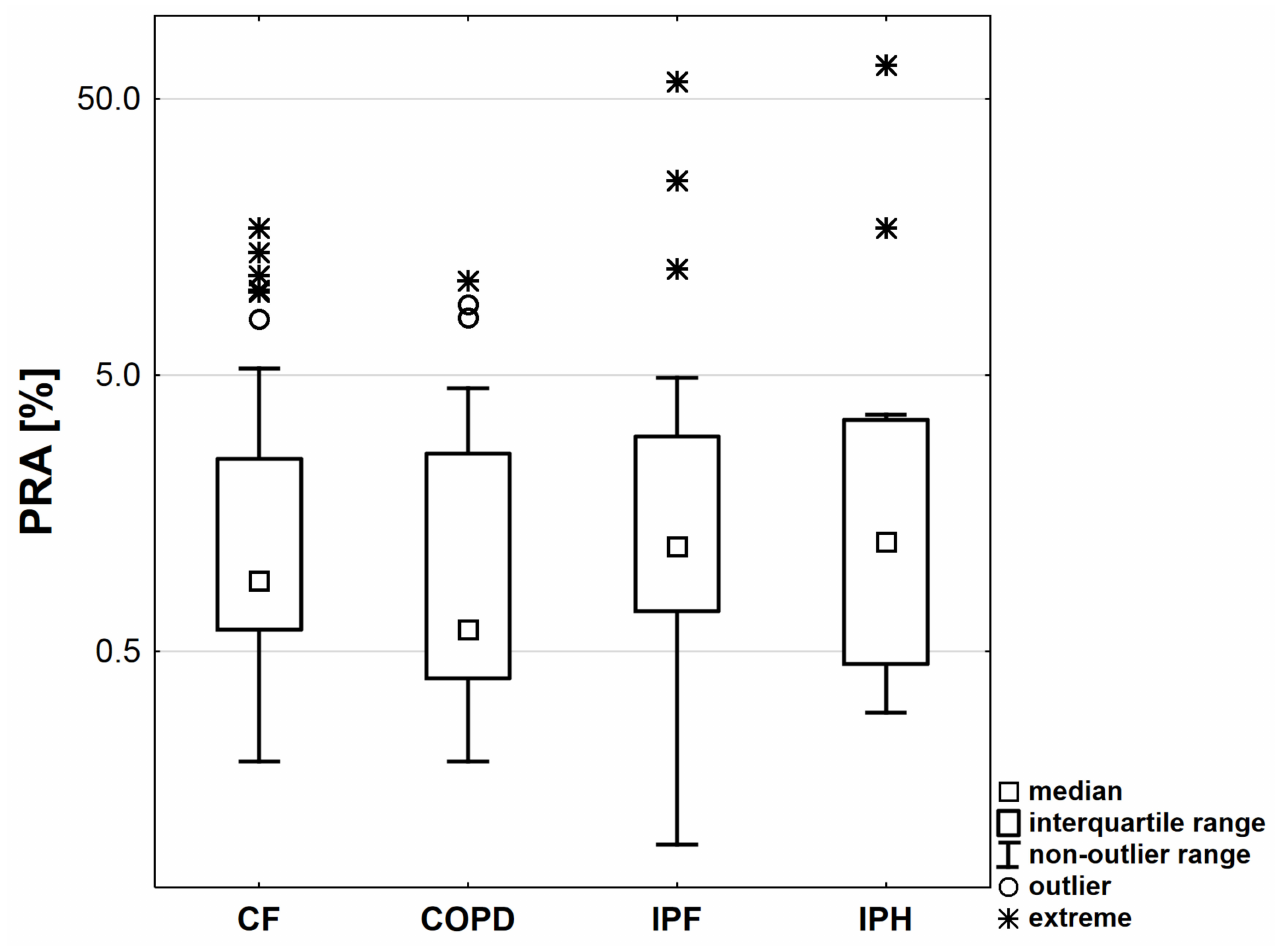
Figure 1. PRA (%) value depending on the disease. In the graph, the square markers represent the median, the boxes represent the interquartile range and the whiskers the range of non-outliers (o—outliers and *—extreme values).